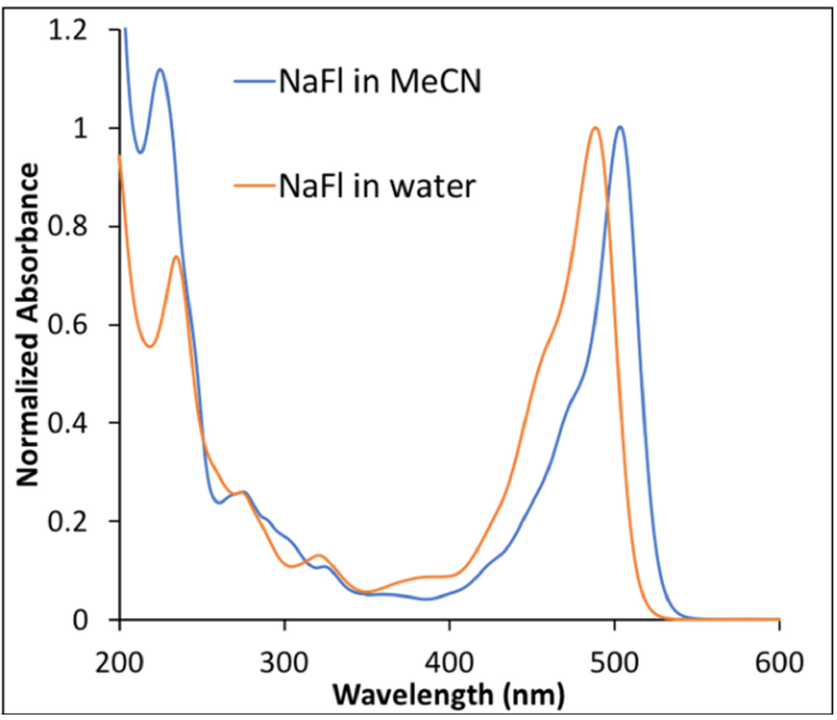
Figure 1. Normalized absorption spectra of NaFl in water and in MeCN. Sustain. Chem. 2021 , 2 , FOR PEER REVIEW